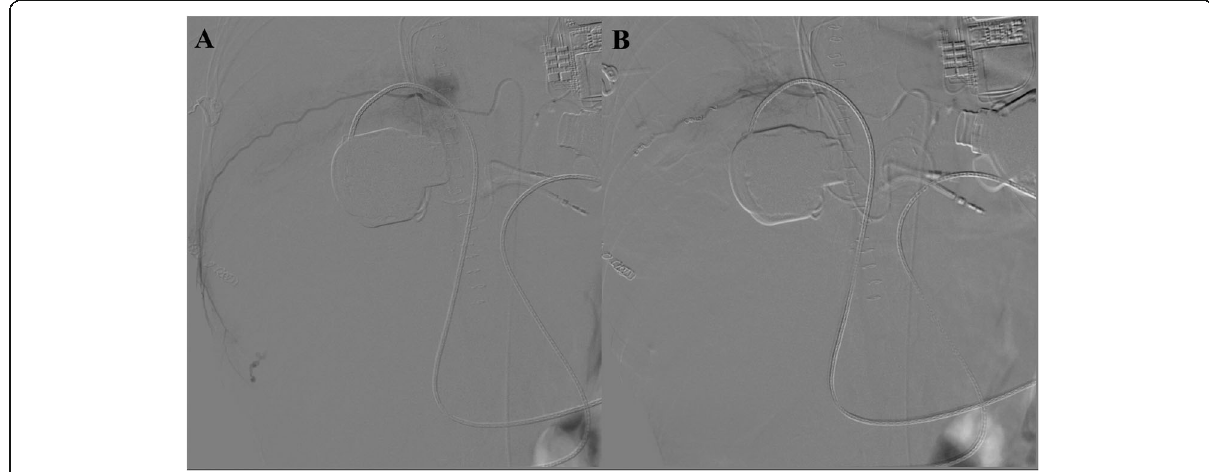
Fig. 6 ( a ) Diagnostic angiography confirmed the presence of bleeding from the IX intercostal right artery. ( b ) Angiography image shows the absence of active bleeding at the end of the